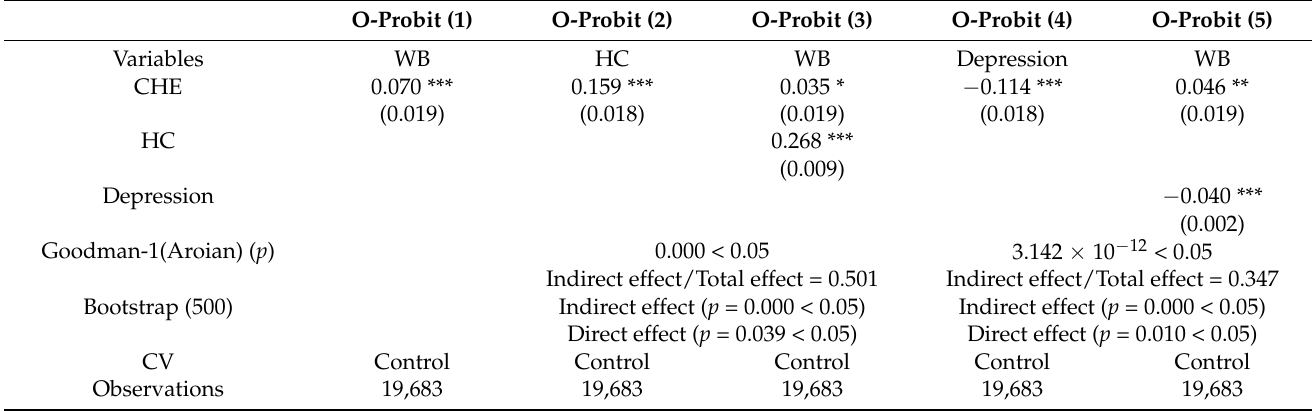
Table 7. The results of mediating effect test for CHE and WB:HC and